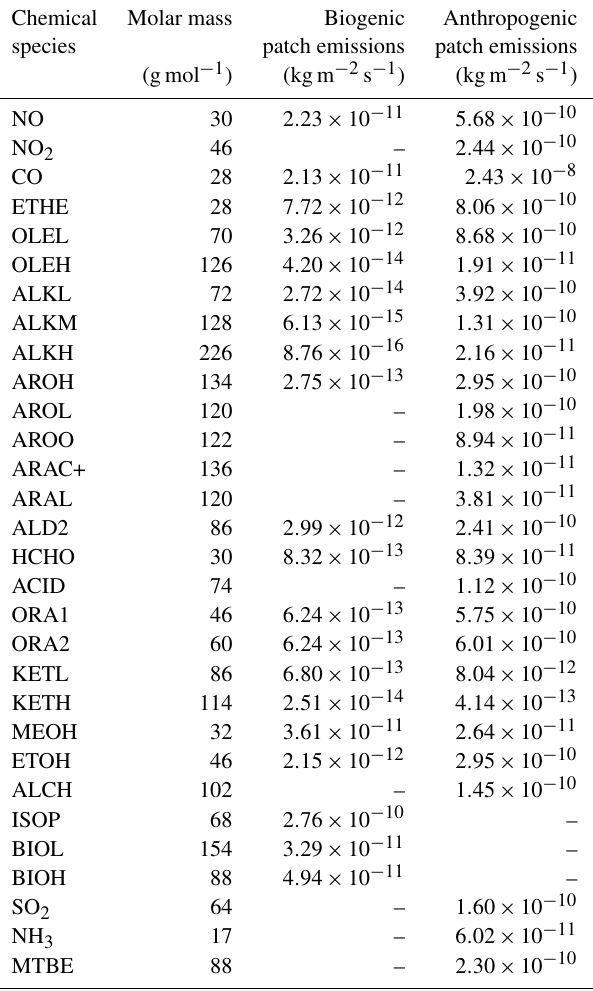
Table 2. Emission values for the biogenic and the anthropogenic cases, in kgm 2 s − 1 . For NO, ISOP, BIOL and BIOH in the biogenic case, Gaussian shape emissions were set and only the maximum value is indicated here. Please see text for